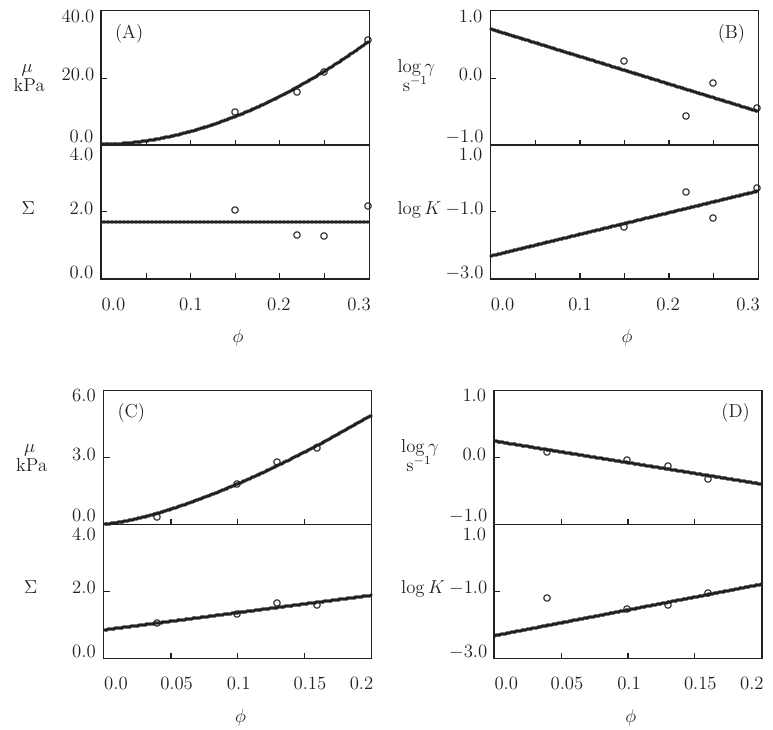
Figure 13. Parameters µ , Σ ( A , C ) and γ , K ( B , D ) versus concentration of proteins φ . Circles: treatment of observations on P 4 ( A , B ) and CCK-CCE ( C , D ) gels. Solid lines: the results of